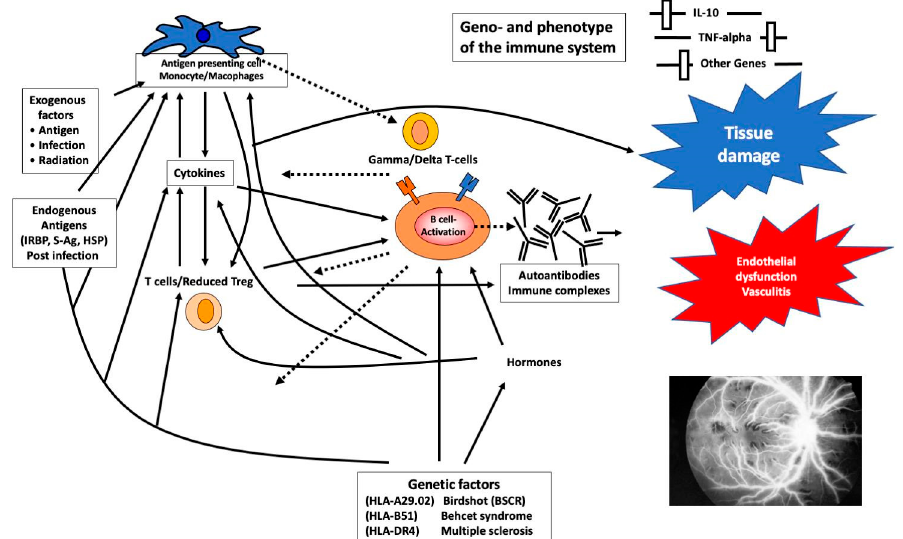
Figure 1. Schematic representation of the pathophysiology and influencing factors in retinal vasculitis. Highly simplified representation of the exogenous and endogenous factors that lead to an immune response in retinal vasculitis. Innate and acquired immunity as well as genetic factors result in vasculitis and subsequent tissue damage. Exogenous factors such as foreign antigens and infectious agents are processed by antigen-presenting cells, which result in B-cell activation. Endogenous antigens such as retinal S antigen can also result in immune stimulation and cytokine release. Both endogenous and exogenous antigen-mediated immune stimulation are controlled by genetic factors. Resultant cytokine release and antigen–antibody complexes result in tissue (endothelial) dysfunction, which is a hallmark of retinal vasculitis. HLA, human leukocyte antigen; HSP, heat shock protein; IL, interleukin; IRBP, interphotoreceptor retinoid binding protein; S-AG, retinal protein S-Ag.